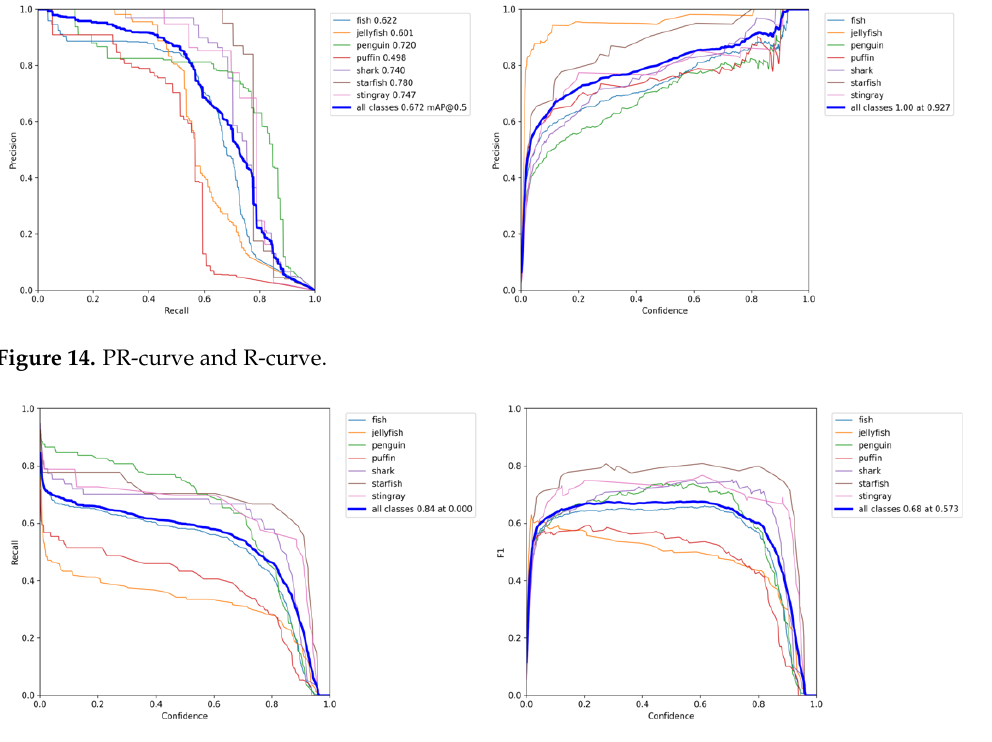
Figure 15. F1-curve and